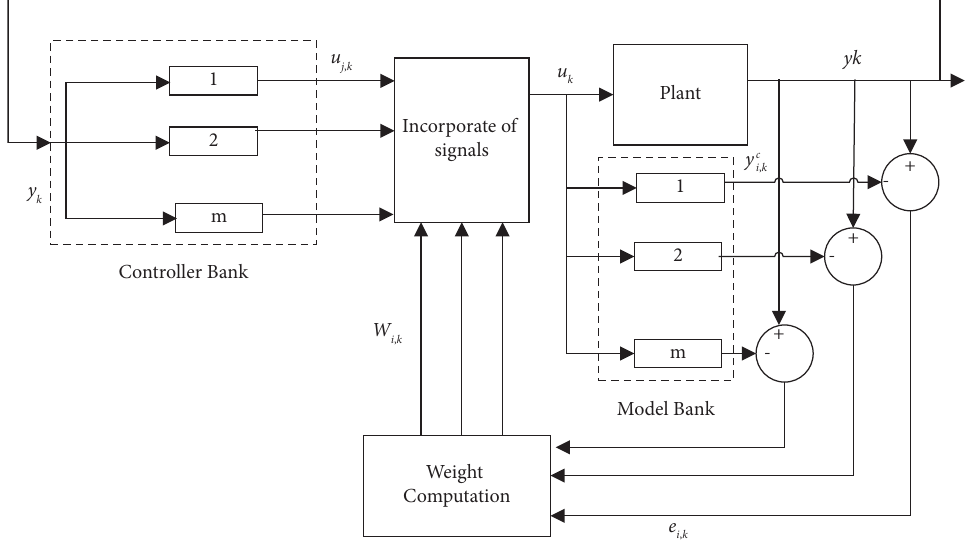
Figure 1: Te multiple-model control